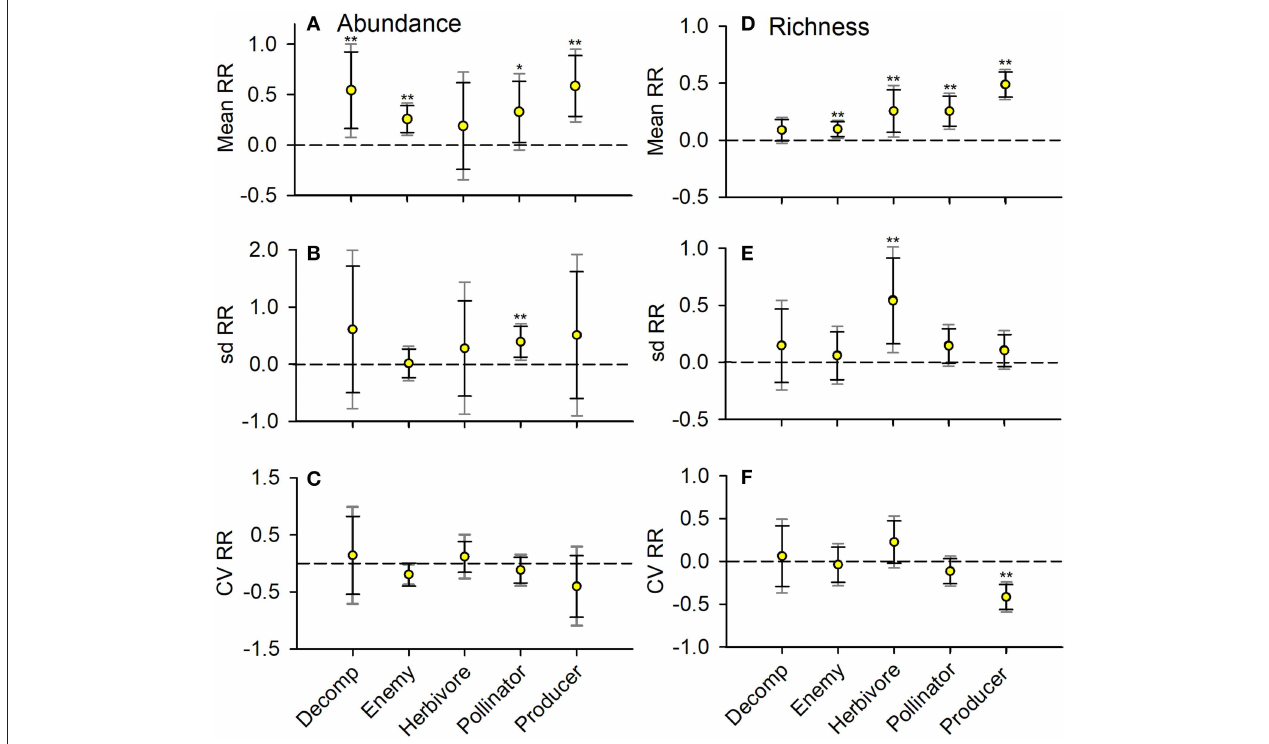
FIGURE 3 | Functional group (decomp = decomposer, enemy = natural enemy, herbivore, pollinator, producer) (A) abundance mean response ratio, (B) abundance standard deviation response ratio, (C) abundance coefficient of variation response ratio, (D) richness mean response ratio, (E) richness standard deviation response ratio, and (F) richness coefficient of variation response ratio. All values shown are means ± 90% CI (black) and ± 95% CI (gray). *Indicates 90% CI did not overlap 0; **indicates 95% CI did not overlap 0.